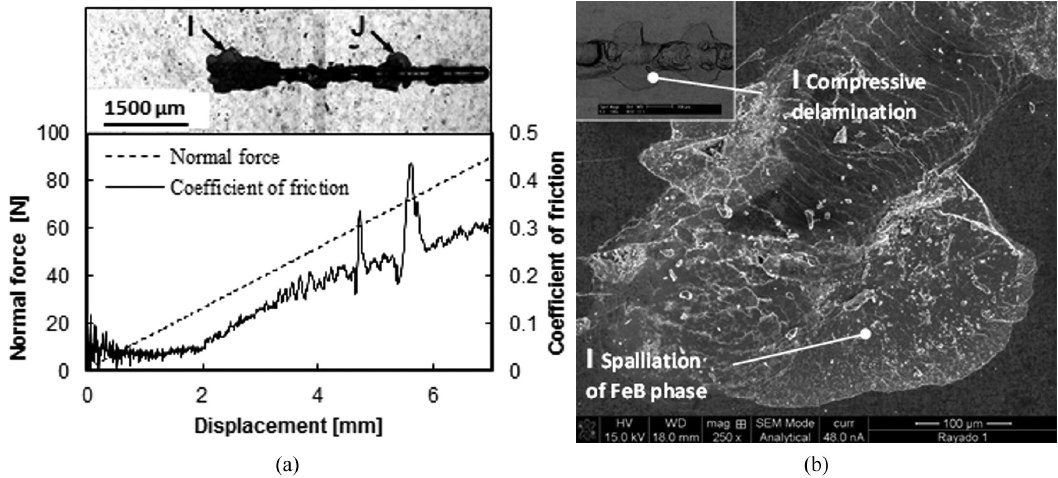
Figure 10. SEM micrographs of scratch test on AISI 304 steel borided at 1223 K during 10 h of exposure time: (a) Correlation between CoF and occurrence of damage, (b) Spalliation and compressive delamination mechanisms. Table 1. Critical loads and failures mechanisms produced by scratch test on AISI 304 steel borided at 1223 K. Exposure time Critical